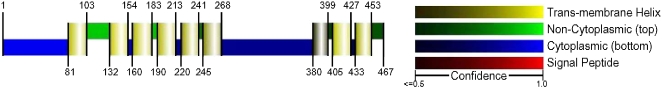
Philius topology prediction for the human presenilin protein as shown on the YRC web-page.The diagram shows the nine membrane-spanning regions as vertical cylinders, and the cytoplasmic and non-cytoplasmic segments as horizontal bars. Each segment is colored according to type and shaded according to the confidence score. The seventh membrane-helix is missed by many topology predictors and is assigned a relatively low confidence score by Philius and as such is shaded gray. Because of this one low-confidence membrane segment, the location of the C-terminus is less confidently assigned than the location of the N-terminus. On the YRC web page, this diagram is accompanied by the type confidence and topology confidence, as well as a copy of the protein sequence, color coded by segment type. Placing the mouse over any part of the topology diagram or the color-coded sequence will produce a pop-up showing the segment type, confidence, and boundary locations.